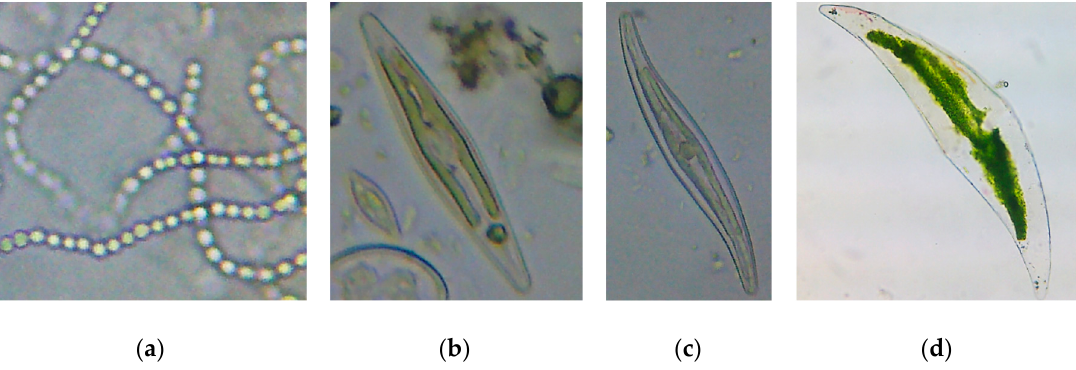
Figure 8. Examples of algae that can be used for ecotoxicity assessment: ( a ) cyanobacteria; ( b ) diatoms and ( c,d ) green algae.